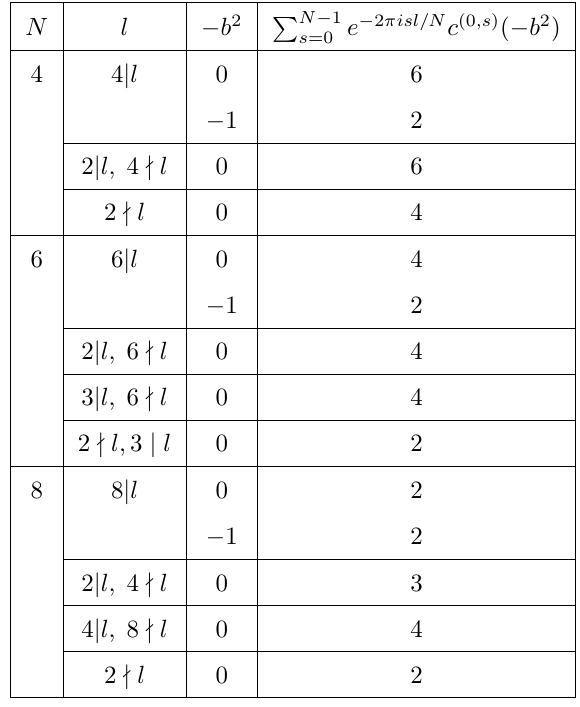
Table 2 . Values of P N − 1 e − 2 πisl/N c (0 ,s ) ( − b 2 ) for non-prime CHL orbifolds of K 3 s =0